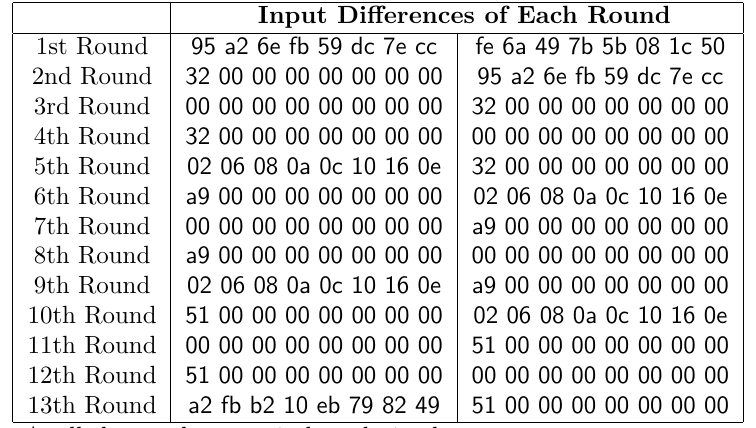
Table 2: Differential of the Experiment Pair for 12-Round Chosen-Key Distinguisher Input Differences of Each